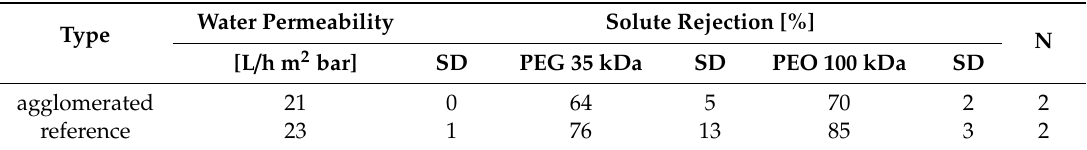
Table 3. Ultrafiltration performance of PVDF membranes prepared without PVP at 50% w / w (PVDF) zinc oxide without and with sonication of the nanofiller during dope solution